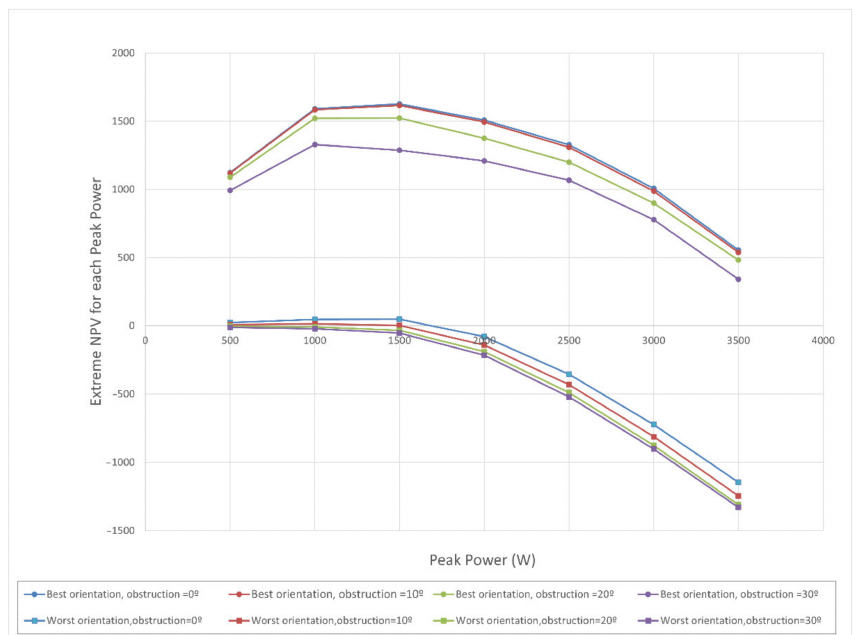
Figure 7. NPV depending on peak power and degree of obstruction for optimal orientation and worst